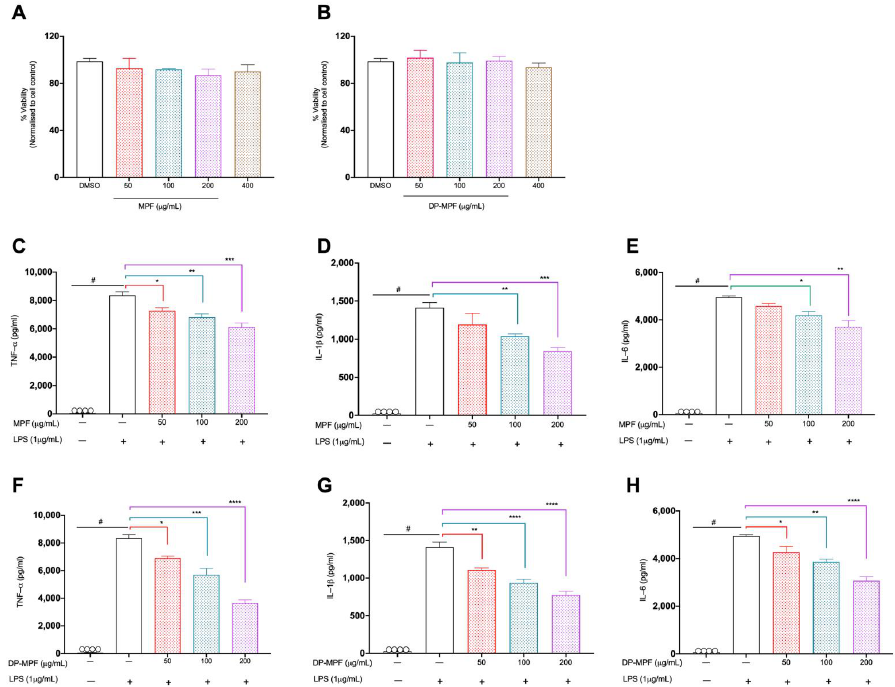
Figure 1. ( A, B ). Effects of MPF and DP-MPF on raw 264.7 macrophage cell line viability. Cells were treated with the specified concentrations of fucoidan extract ( A ) MPF and ( B ) DP-MPF for 48 h and assessed by MTT assay. Results expressed as % viability of treated cells vs. vehicle control. ( C – H ). Effects of MPF and DP-MPF on pro-inflammatory cytokines, TNF- α, IL - 1β, and IL -6 in LPS-stimulated raw 264.7 cell line. Cells were pre-treated with the indicated doses ( C – E ) MPF and ( F – H ) DP-MPF for 24 h, followed by LPS stimulation for 24 h. TNF- α, I L- 1β, and IL -6 were measured from the supernatant using ELISA. Data expressed as means ± SEM. Statistical significance was carried out using one- way ANOVA followed by Tukey’s multiple comparison test (n = 3). # Significant effect HC vs. DSS ( p < 0.05); * Significant effect treatment vs. DSS (DSS vs. MPF) or (DSS vs. DP-MPF). A p -value of < 0.05 was considered significant. * p < 0.05, ** p < 0.001, *** p < 0.0001 and **** p < 0.00001.